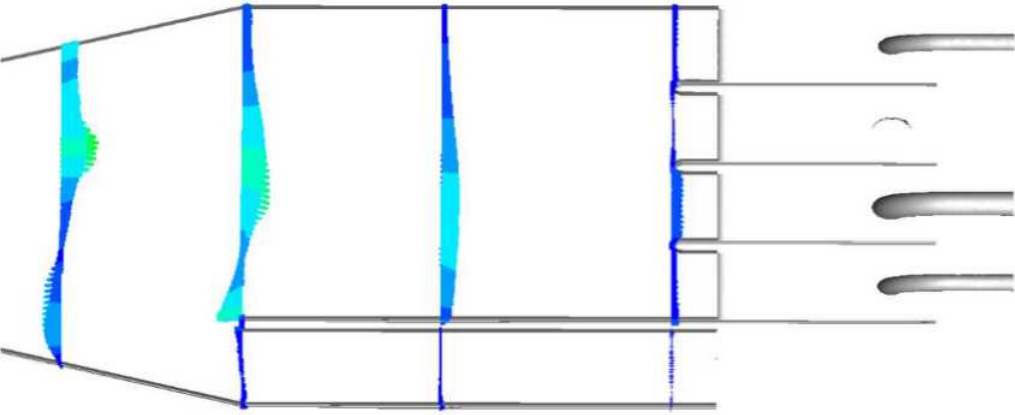
Figure 9. The velocity vector of the approach diagram.